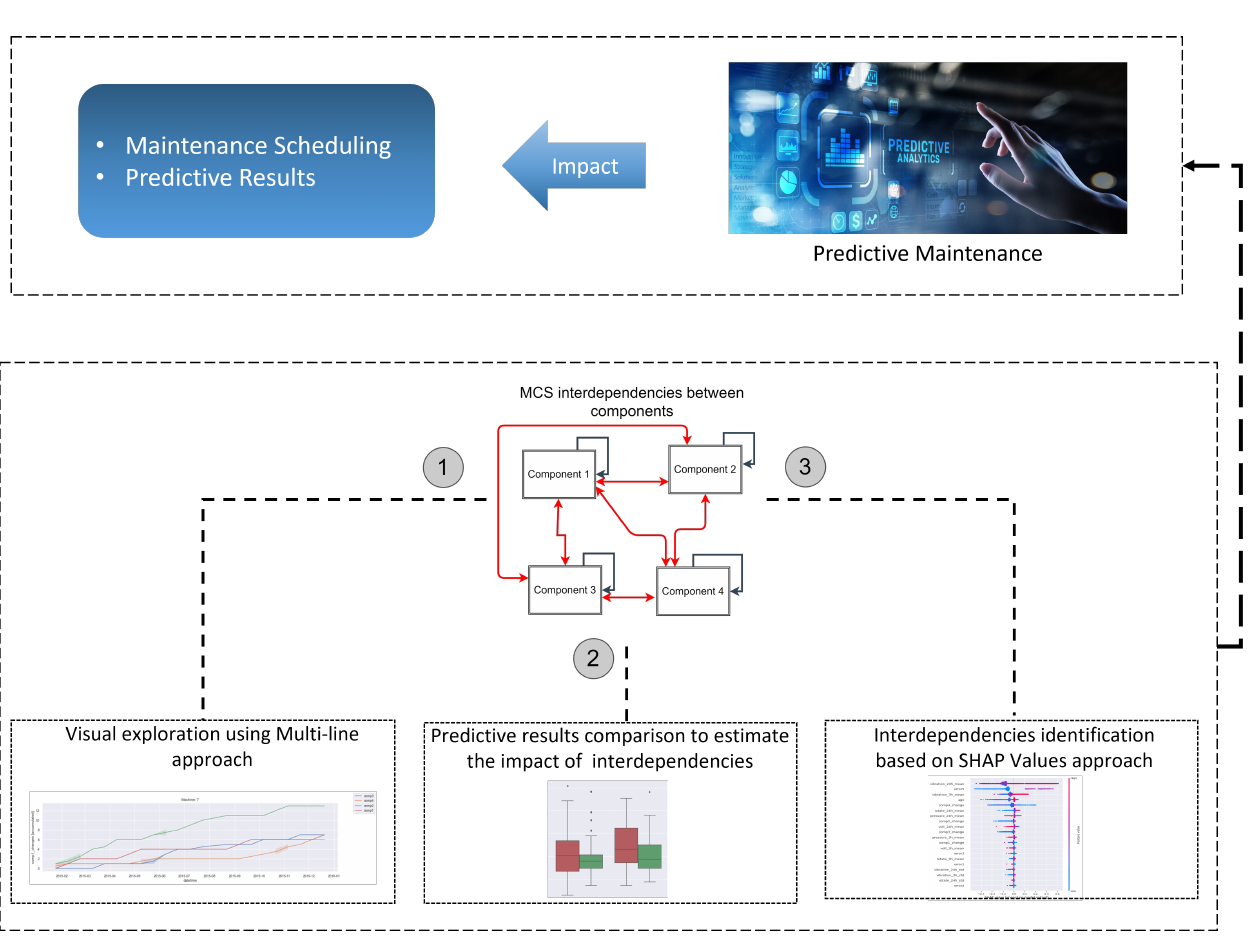
Figure 3. Framework overview to identify and show the impact of interdependencies in the context of predictive maintenance. (1) visual inspection based on multi-line chart to explore interdependencies, (2) predictive model comparison to show the impact of interdependencies, and (3) SHAP visualization to explain the component